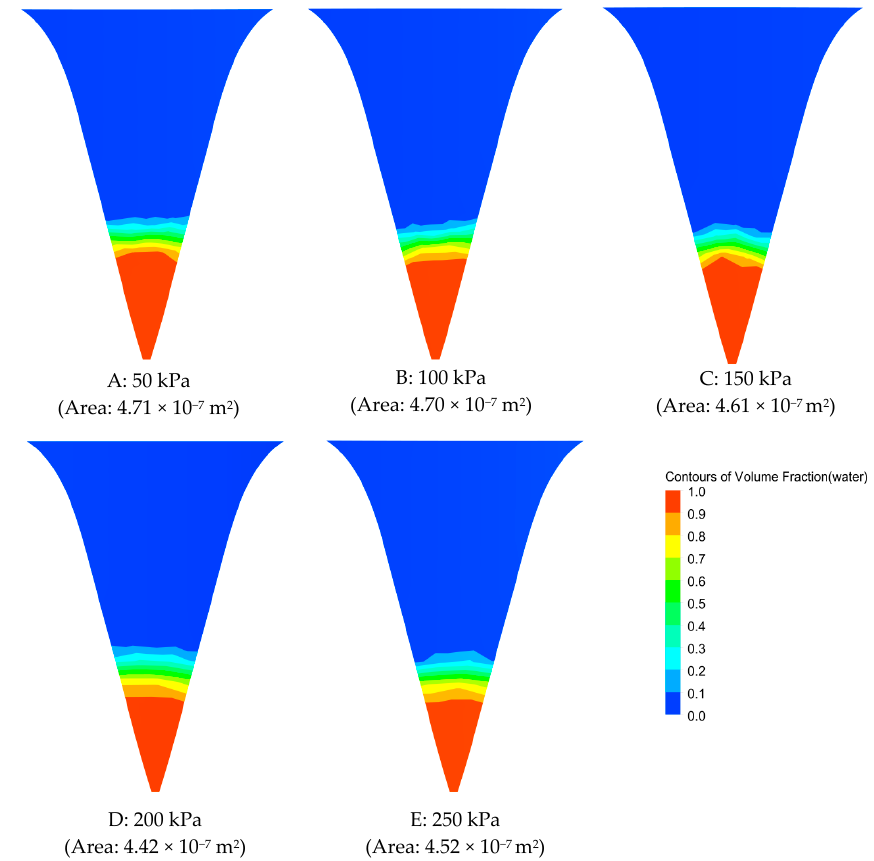
Figure 6. Water surface profile of the third groove with a nozzle diameter of 3.97 mm.